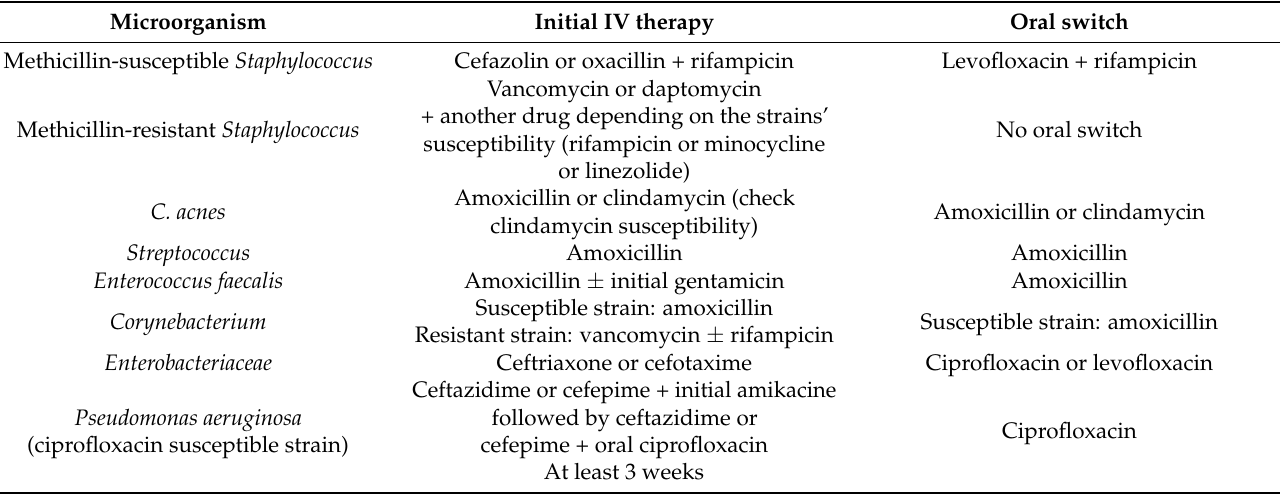
Table 2. Pathogen-specific first-choice antibiotic